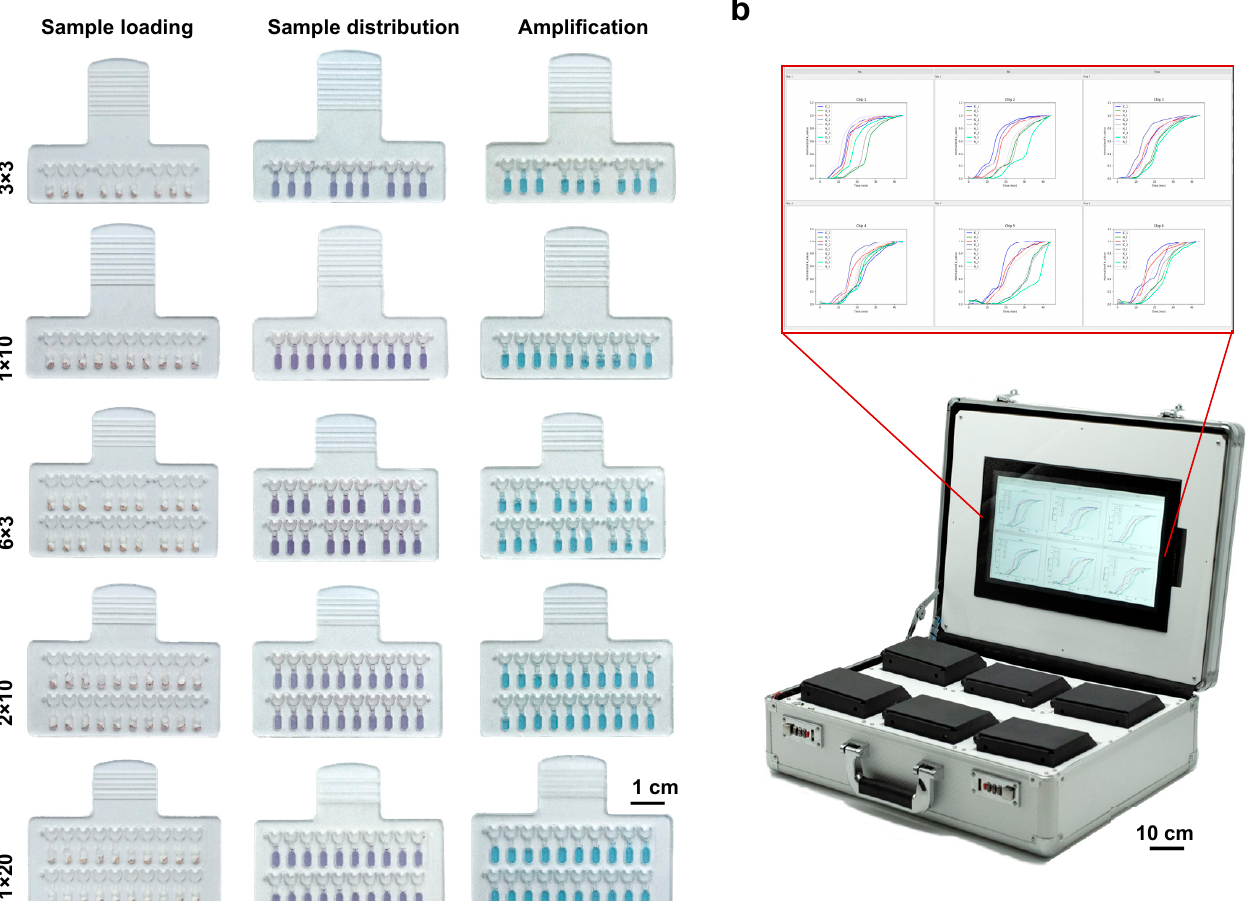
Figure 5. Ability of our SMART system in multitarget and multi-sample detection. ( a ) Illustration of the chips with different designed structures for detecting multiple targets and multiple samples. ( b ) Photograph of the mobile suitcase accommodating six SMART analyzers and the user interface for signal